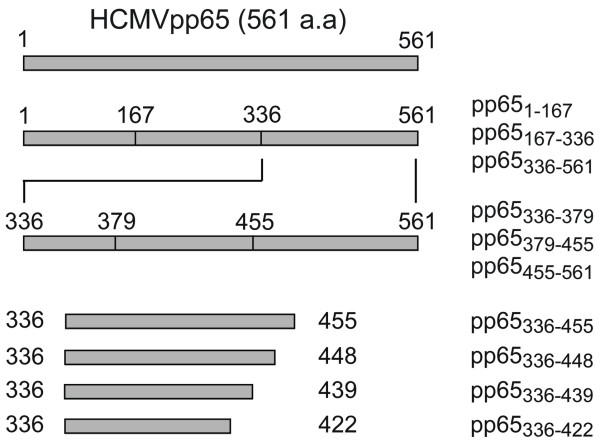
Schematic representation of truncated HCMVpp65 His-tag fusion proteins (Swiss-Prot: P06725). The full-length of HCMVpp65 is given in the top figure. Below that, six pp65 sub-fragments, pp651-167, pp65167-336, pp65336-561, pp65336-379, pp65379-455, pp65455-561, and four C terminal truncated peptides, pp65336-422, pp65336-439, pp65336-448, pp65336-455, are shown. The name of the plasmids which encoded pp65 sub-fragment proteins are given at the right. HCMVpp65, human cytomegalovirus phosphoprotein 65 (65 kD).